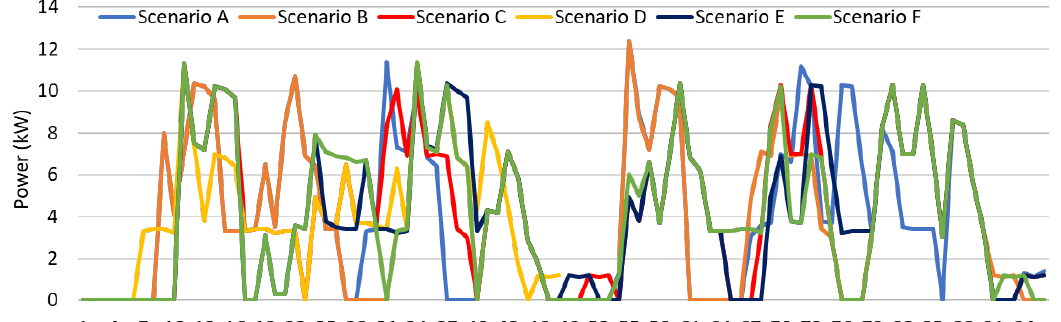
Figure 11. Total power consumption of devices in all scenarios.